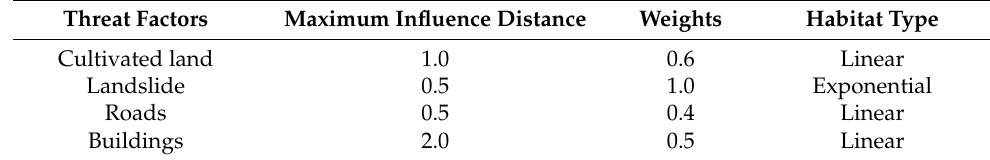
Table 3. The maximum influence distance and weight of different threat factors.